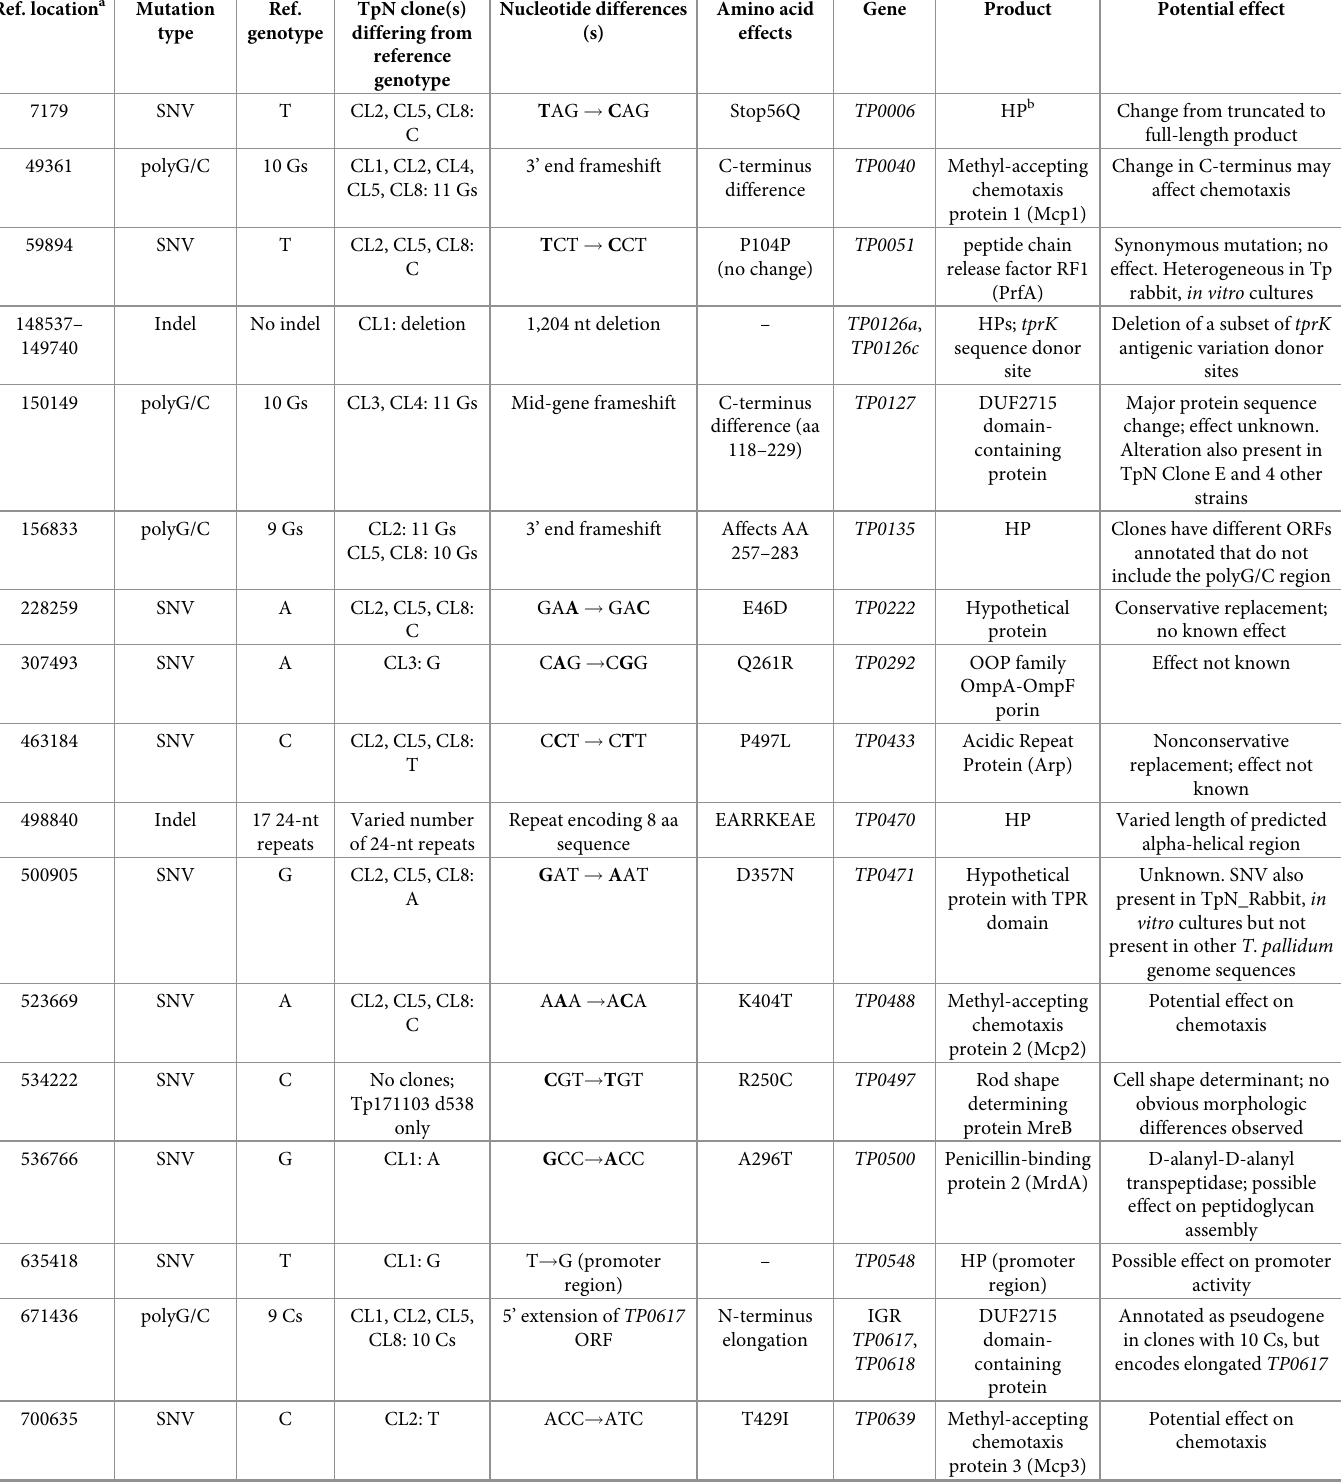
Table 3. Potential biological effects of T . pallidum Nichols sequence